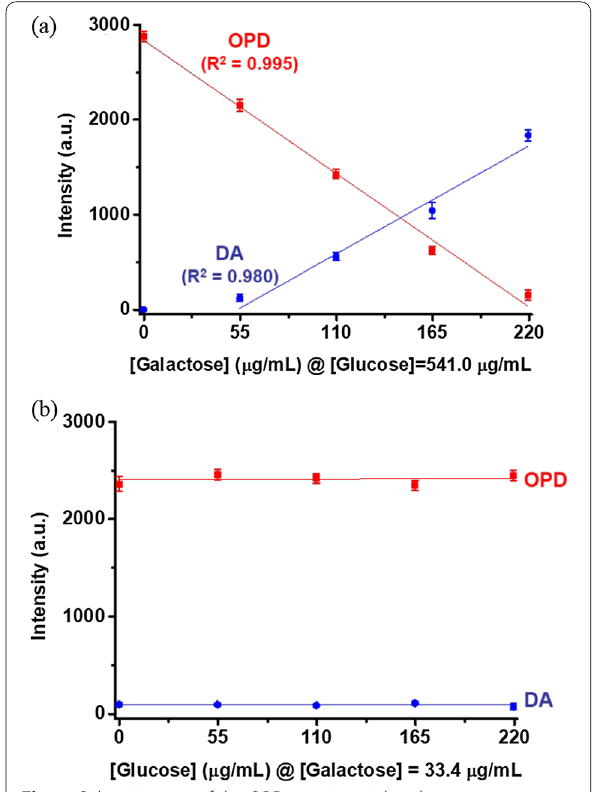
Fig. 4 Selectivity test of the OPD reaction with galactose concentration under the interference of glucose. a Mass spectra of OPD assay products with different concentrations of galactose and a fixed concentration of glucose (541.0 μg/mL). b Mass spectra of OPD reaction products with different concentrations of glucose and a fixed concentration of galactose (33.4 μg/mL)